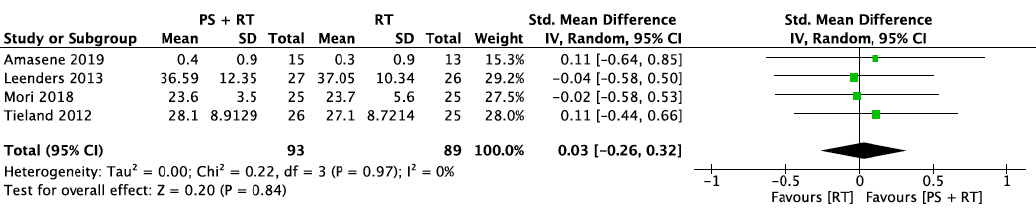
Figure 6. Impact of RT + PS on handgrip strength.